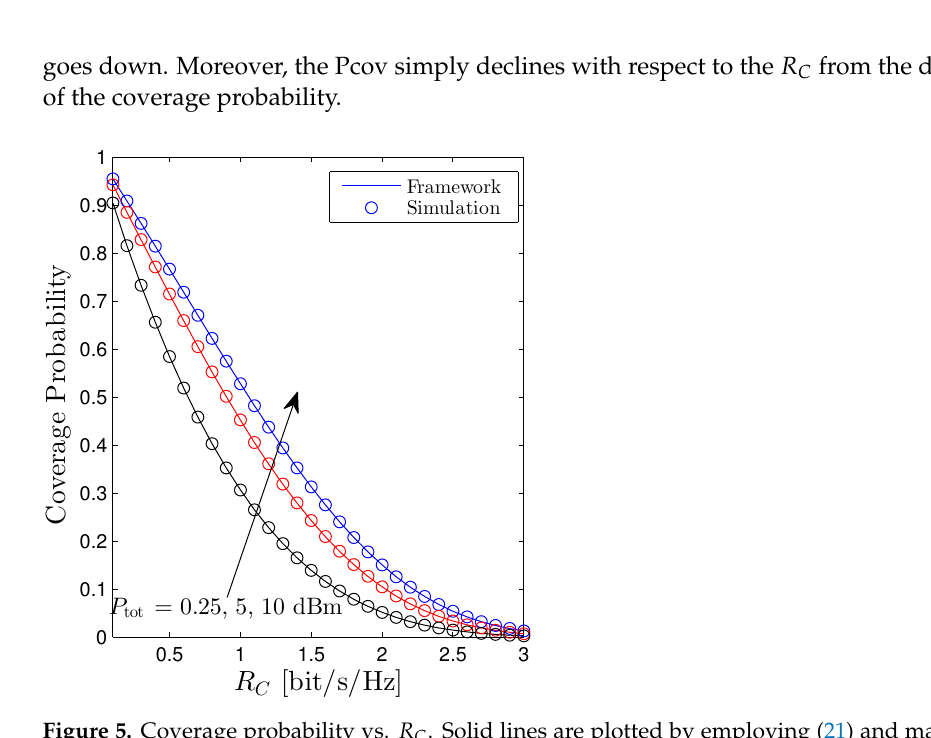
Figure 5. Coverage probability vs. R C . Solid lines are plotted by employing (21) and markers are Monte Carlo simulation.